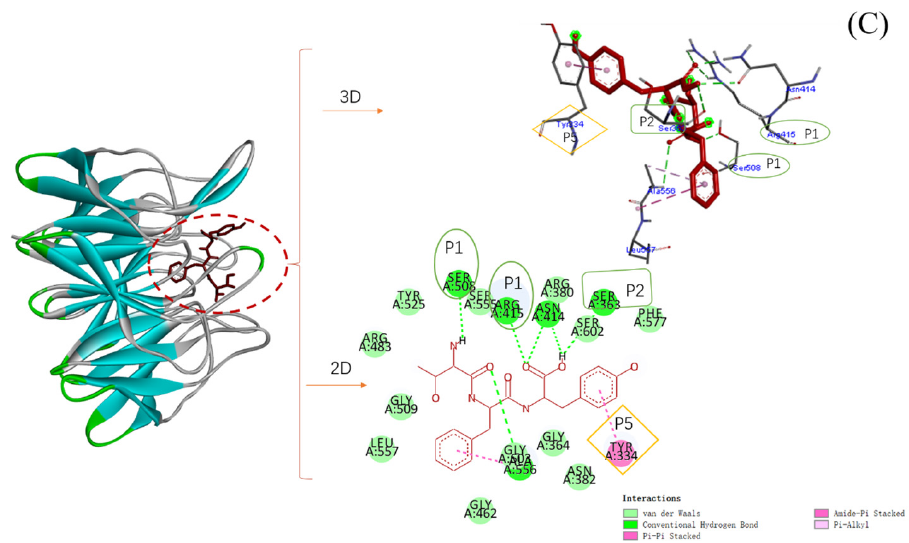
Figure 9. The 2D and 3D interactions between Keap1 (4IQK) and pea antioxidant peptides. ( A ) Peptide 1 YLVN. ( B ) Peptide 2 EEHLCFR, and ( C ) Peptide 3 TFY. Table 3. Keap1 (4IQK) docking results and interaction sites with pea antioxidant peptides.